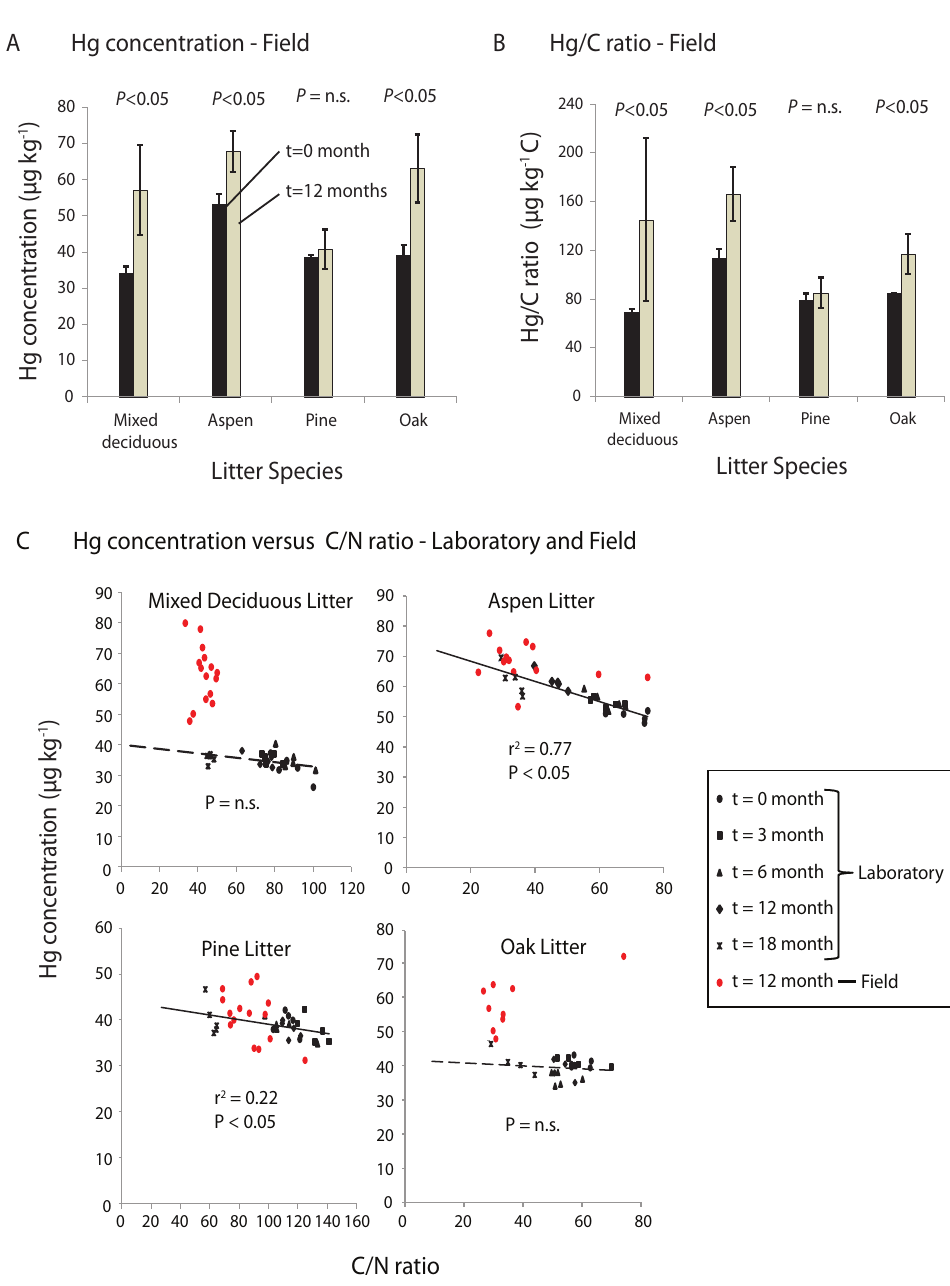
Fig. 3. (A) : Hg concentrations of field samples prior to ( t = 0 month) and after ( t = 12 months) one year of exposure in the field. Bars represent means ± standard deviations of 15 replicate samples. P -values are based on paired t-tests. (B) : same as panel A for Hg/C ratios. (C) : scatter plots of Hg concentration and C/N ratios of all litter samples in the laboratory decomposition study (black symbols). Samples at different harvest times are marked with different symbols. Regression line marks linear trendline (solid line when P < 0 . 05) between Hg and C/N ratios in laboratory samples. Red symbols are Hg concentrations, and C/N ratios of samples exposed in the field. In two species, points fall clearly above trendlines for laboratory